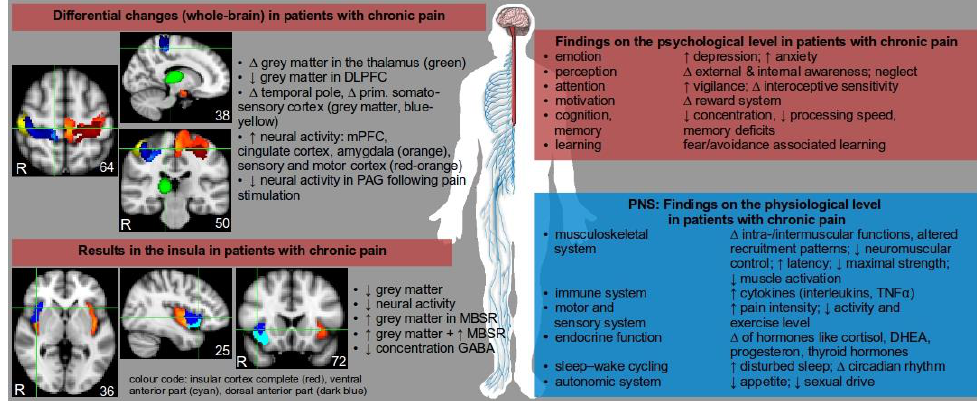
Figure 1. Overview of the complex and multidimensional changes in the central (red area) and peripheral nervous system (PNS, blue area) in patients with chronic pain. ↑ increased, ↓ decreased, ∆ change, + positive relation. Abbreviations: ACTH = adrenocorticotropic hormone, DHEA = dehydroepiandrosterone, GABA = γ-aminobutyric acid, MBSR = mindfulness-based stress reduction, PAG = periaqueductal grey, PFC = prefrontal cortex, TNF = tumor necrosis factor. The content of the picture is not exhaustive, but serves to demonstrate the complexity of chronic pain by listing relevant consequences, cofactors, and epiphenomena. Brain regions displayed on MNI template.